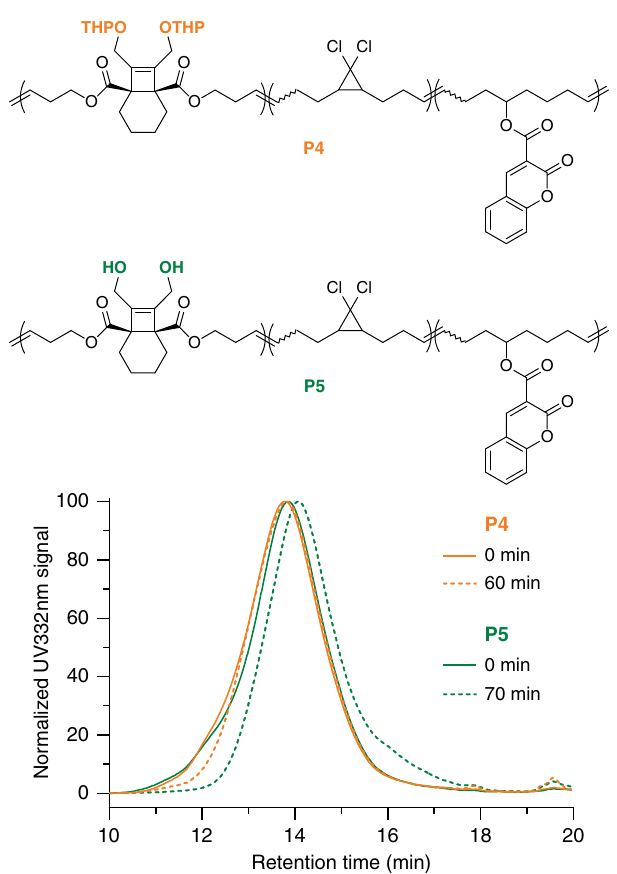
Fig. 8 Extrusion induced degradation of P4 and P5. P4 and P5 were blended into PCL matrix at 2.5 wt% ratio and subjected to extrusion. The UV absorbance at 332 nm ( y- axis) is due to the coumarin co-monomer and allows for selective monitoring of P4 and P5 within the PCL matrix. After 10 days of standing time, P4 (orange) and P5 (green) polymers before (solid line) and after (dash line) extrusion were analyzed. The extrusion time for each polymer is indicated in the